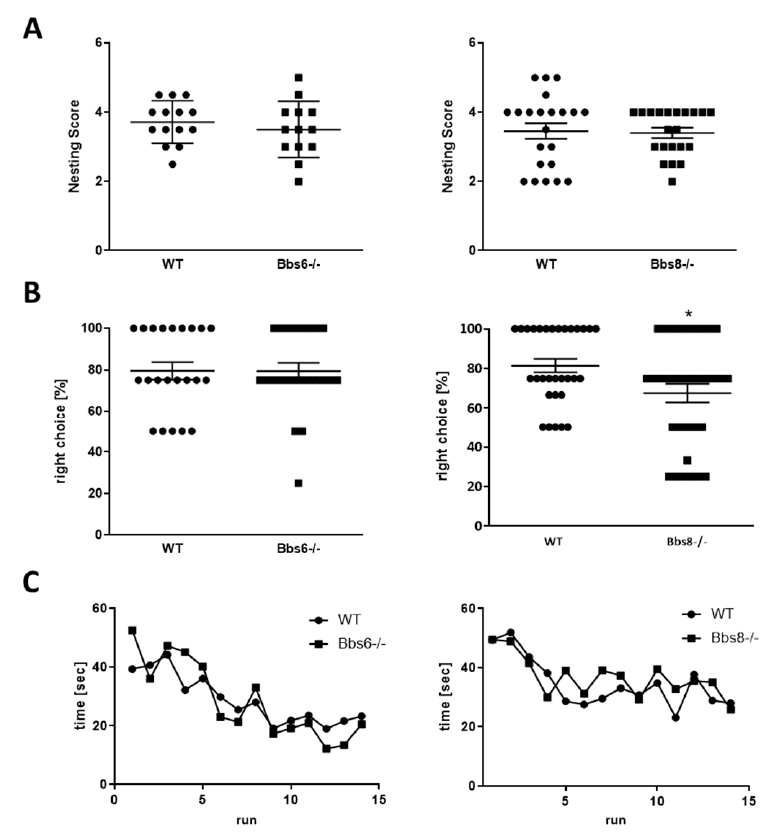
Figure 5. Cognitive performance in Bbs6 and Bbs8 knockout mice. ( A ) Quantitation of nest building ability ( n = 14 for WT, n = 13 for Bbs6 − / − ; n = 22 for WT and Bbs8 − / − ). ( B ) The T-maze test was performed on two different days. Means of both test days are presented ( n = 22 for WT and n = 23 test events for Bbs6 − / − ; n = 32 for WT and Bbs8 − / − ). ( C ) The radial arm water maze was conducted over two days with an overnight rest after the 8th trial ( n = 10 WT and n = 9 Bbs6 − / − animals; n = 22 WT and Bbs8 − / − animals). Student’s unpaired t -test or multiple t -test were used for statistical analysis (* p < 0.05).